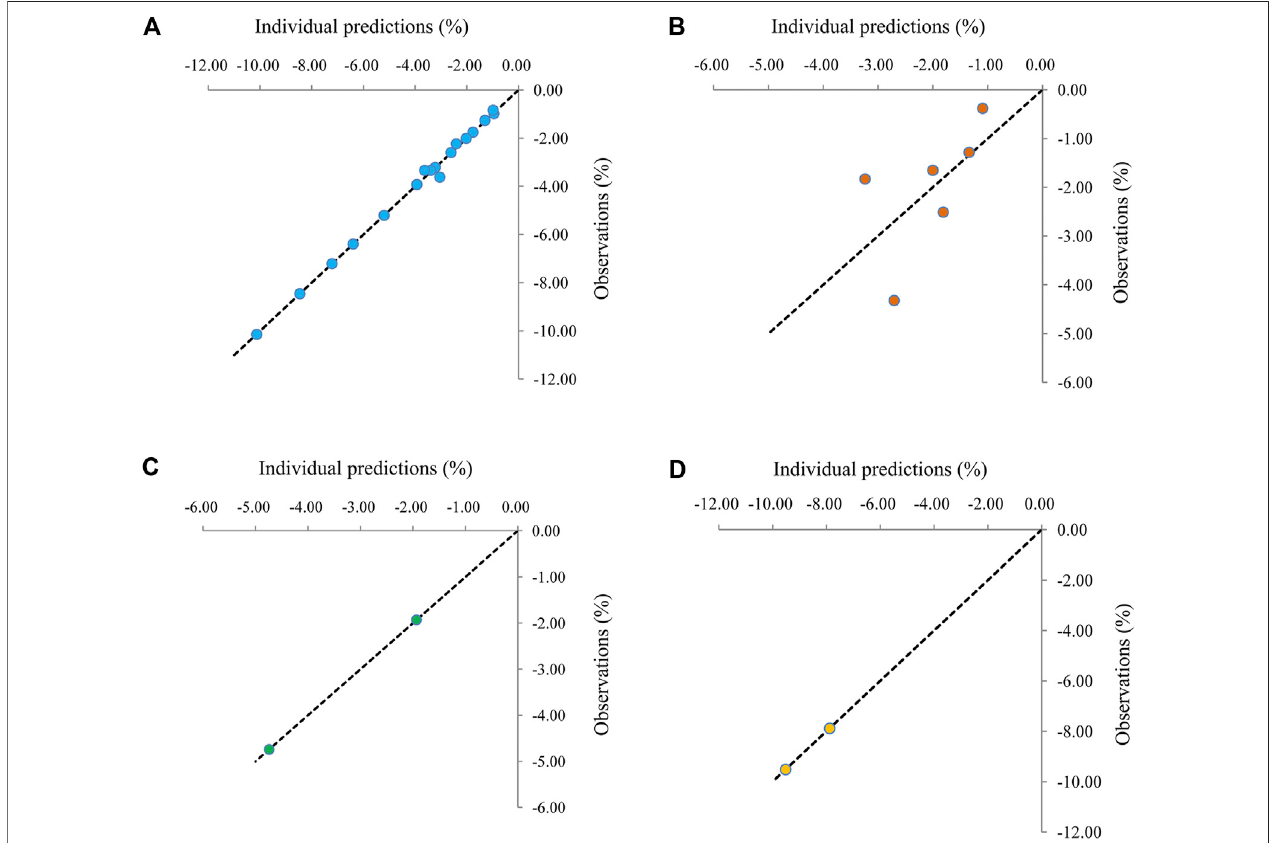
FIGURE 2 | Visual inspection of routine diagnostic plots. (A) Patients with obesity, (B) patients with type 1 diabetes mellitus, (C) patients with nonalcoholic fatty liver., (D) patients with precocity.